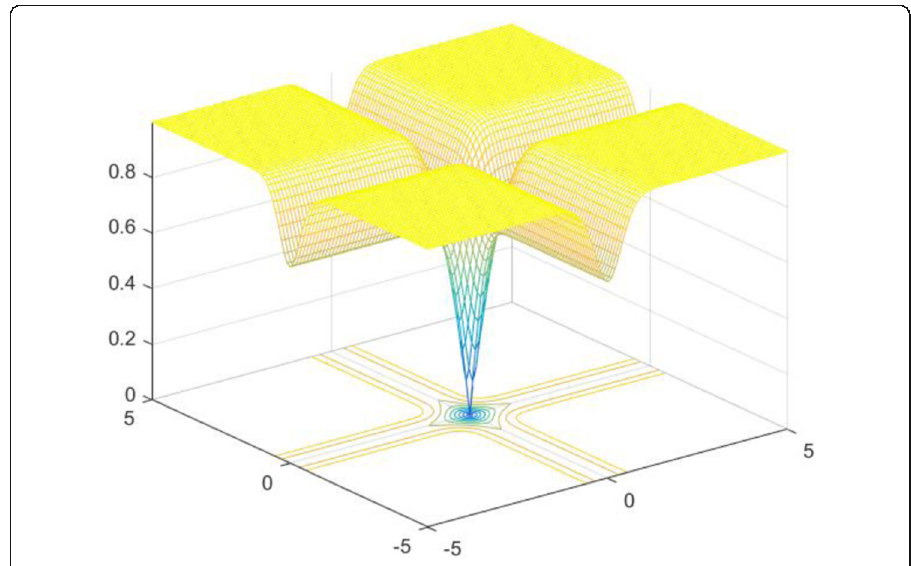
Fig. 5 CIM surface plot showing to distant regions σ = region [18]. In the Euclidean region, CIM behaves as l